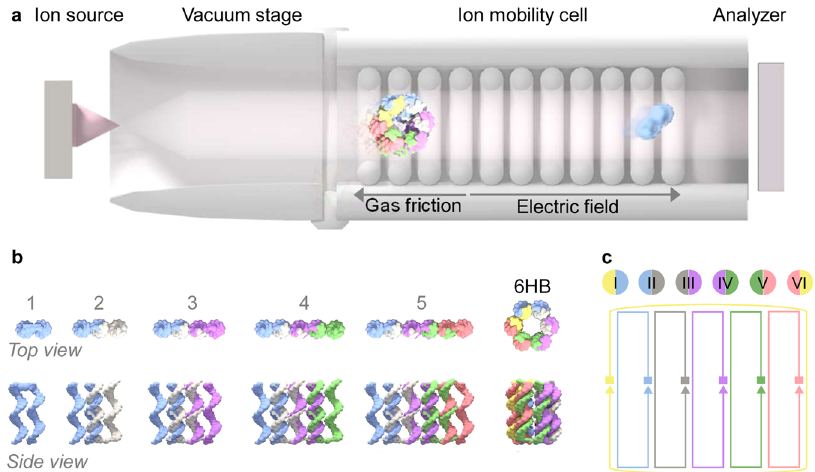
Fig. 1 Native mass spectrometry and ion mobility analysis of DNA nanostructure assembly. a Schematic representation of the experimental setup for native nano-ESI IM-MS. b DNA helical barrel oligomerization from mono- (1) to pentamer (5) via pairwise double helix formation, and model of the hexameric helix bundle structure (6HB; individual strands are indicated in blue, gray, purple, green, red, and yellow). c Oligonucleotide connectivity map of individual DNA strands in the 6HB barrel (square indicates 5 ʹ end and triangle 3 ʹ